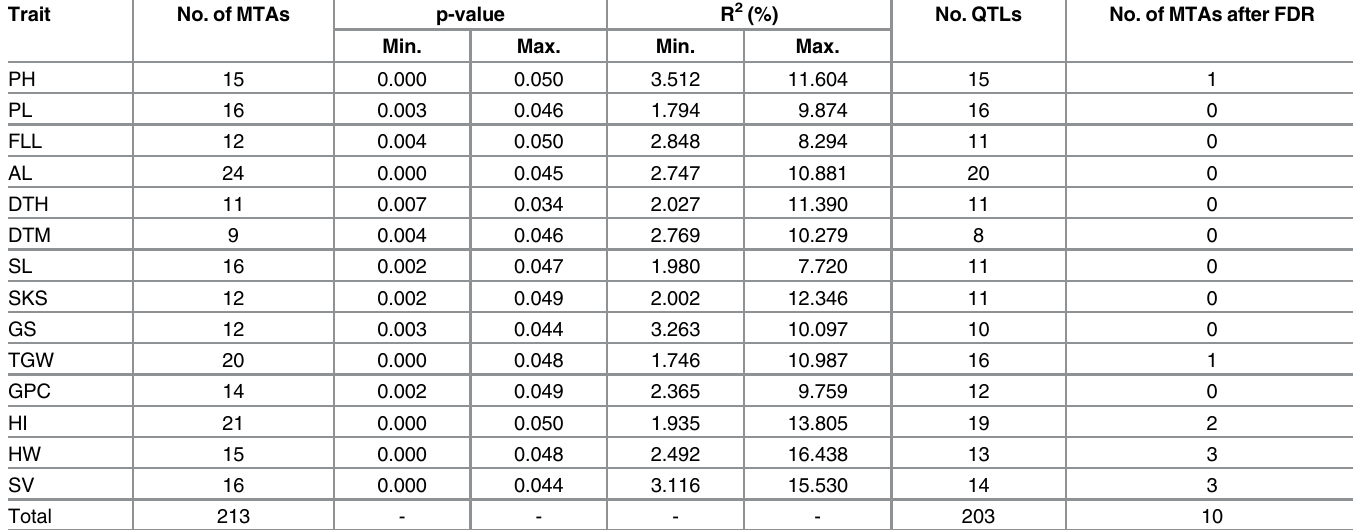
Table 2. Summary of the significant marker-trait associations (MTAs) for 14 traits detected using SLST. The results are referred to significant marker – trait associations on the basis of consistent marker-wise tests (P (cid:1) 0.05) carried out with best fit model of association mapping for individual trait. Trait